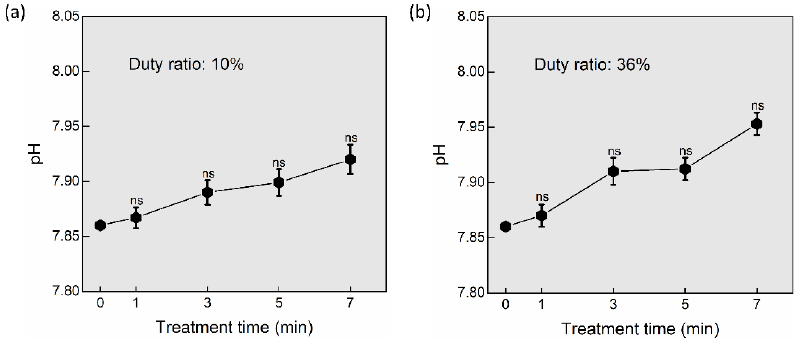
Figure 6. The pH of the PTM (DMEM) after plasma treatment when ( a ) 10% duty ratio and ( b ) 36% duty ratio. The pH remained unchanged or nonsignificant after a plasma treatment time of 1, 3, 5, and 7 min, ns—not significant.